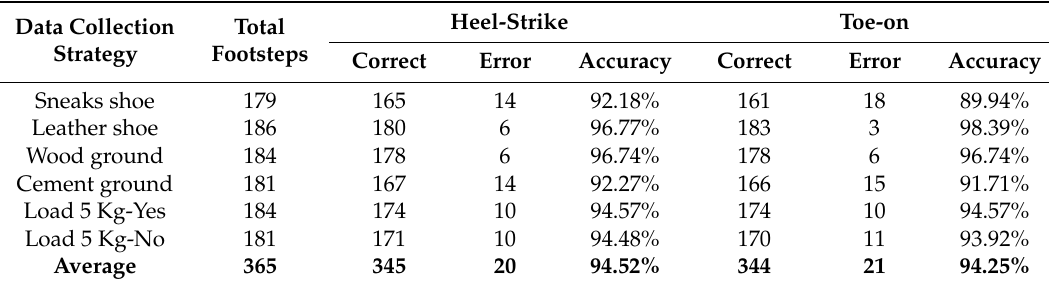
Table 5. Heel-strike and toe-on detection result.